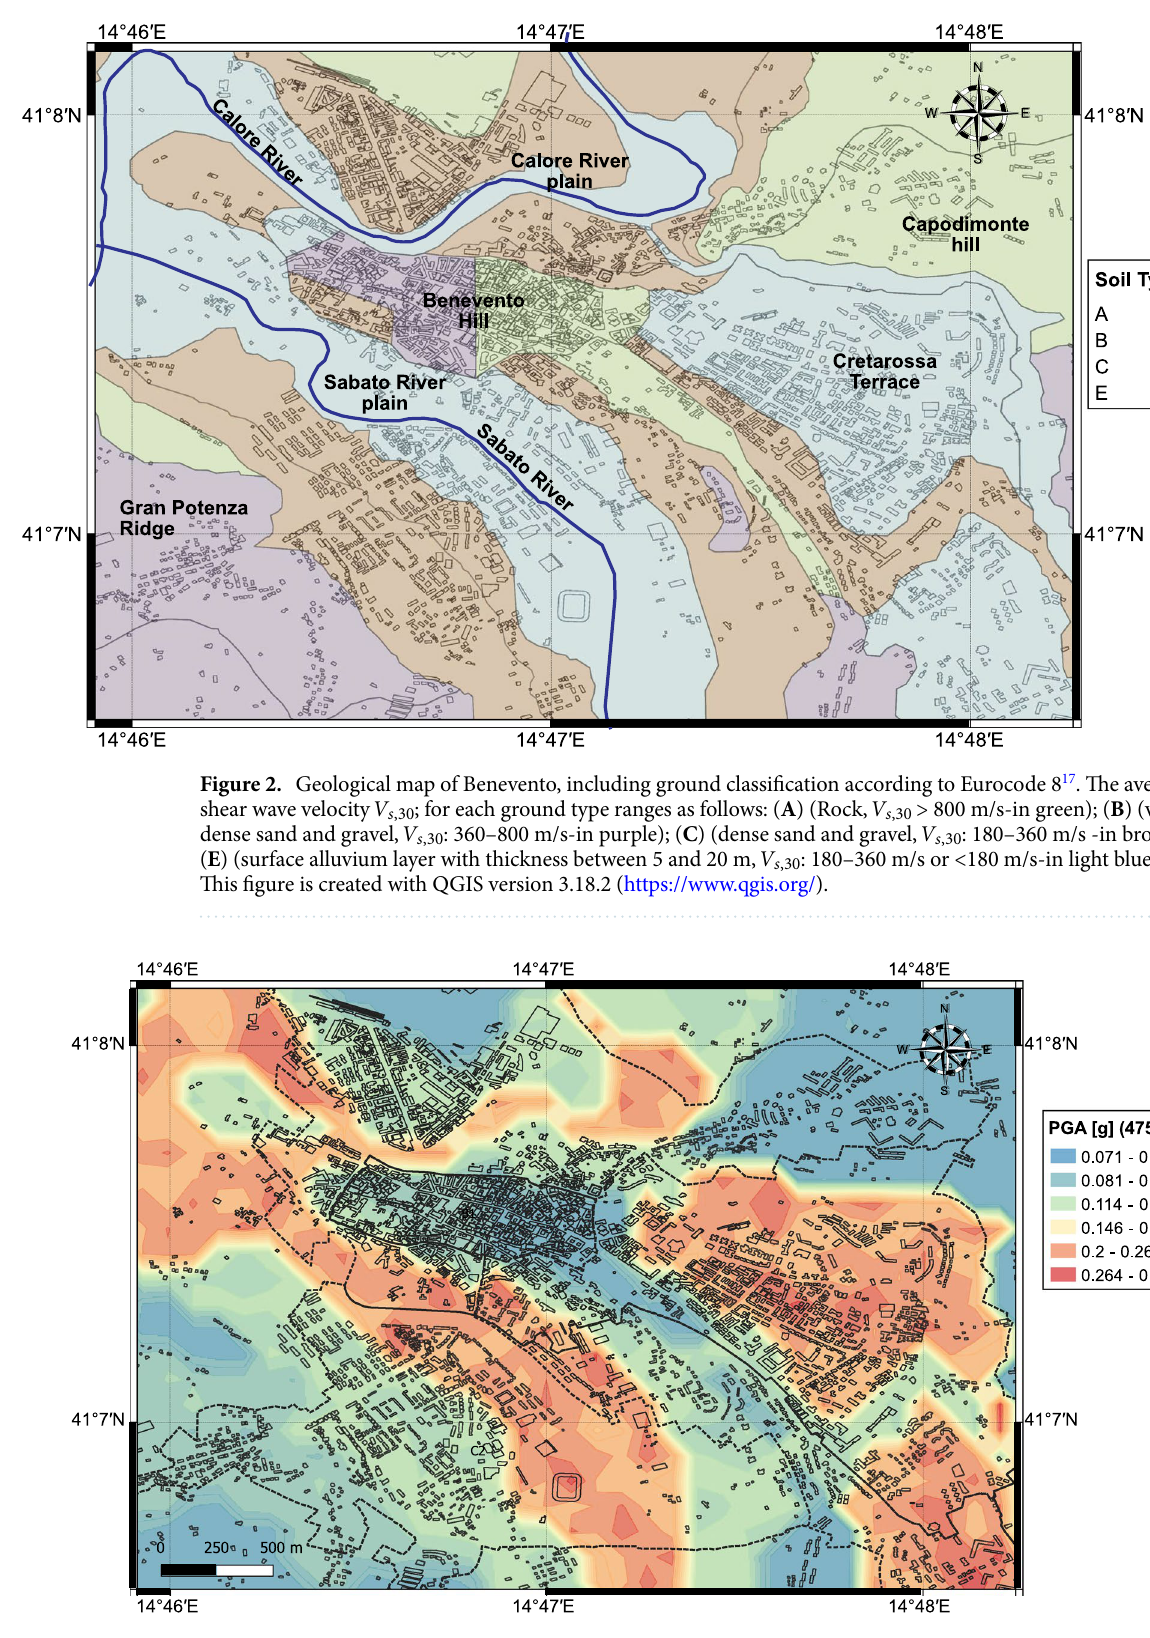
Figure 3. Seismic Hazard model: results express peak ground acceleration values for return period of 475 years (i.e., probability of exceedance of 10% in 50 years). This figure is created with QGIS version 3.18.2 (https:// www. qgis.